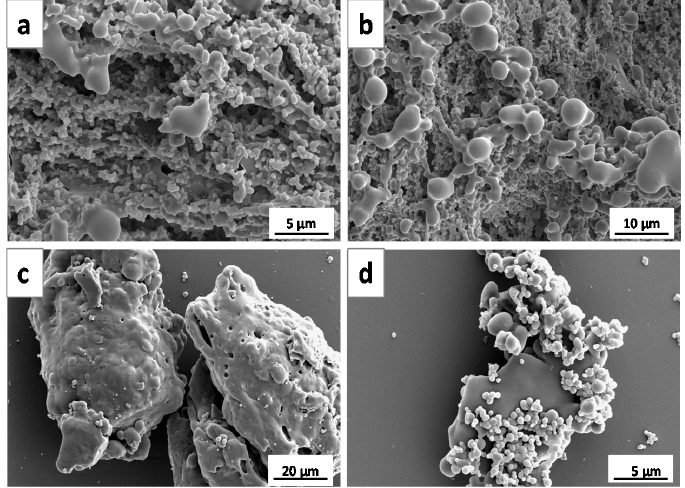
Figure 1. SEM images of a chiral periodic mesoporous organosilica (PMO) system prepared from ligand ( 1 ) with ( a , b ) CTAB and ( c , d ) CTAC surfactants.